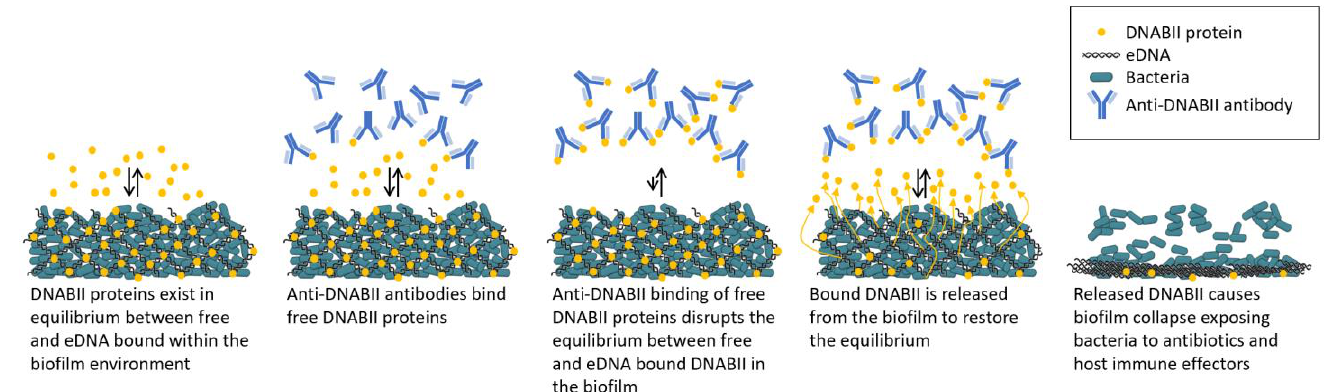
Figure 2. Working model of biofilm collapse following treatment with anti-DNABII antibodies. Adapted from Reference [49].